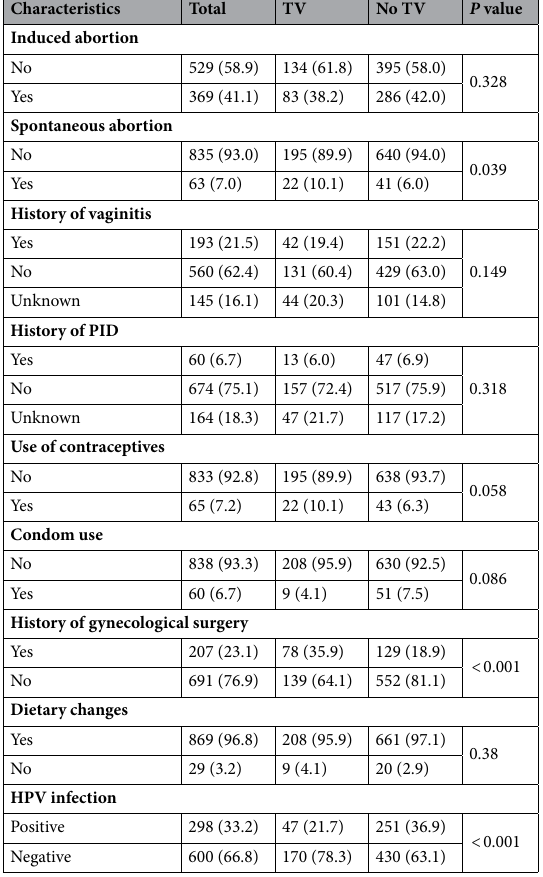
Table 1. Differences between demographic and clinical characteristics of the TV group and the group without vaginitis. PID pelvic inflammatory disease.